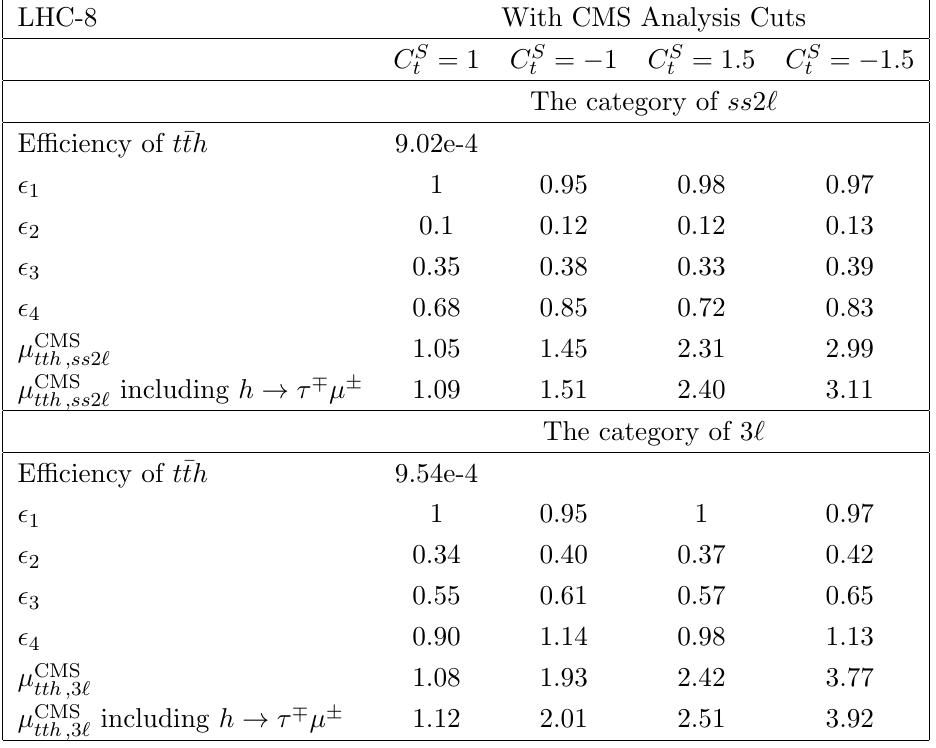
Table 5 . Category Leptons: the D -dependent detection e(cid:14)ciency ratios (cid:15) i ’s de(cid:12)ned in eq. (2.10) p with the CMS cuts for the category Leptons taking C S = (cid:6) 1 ; (cid:6) 1 : 5 and s = 8 TeV. The resulting t signal strengths (cid:22) CMS and (cid:22) CMS are also shown. The last row in each partition shows the values tth;ss 2 ‘ tth; 3 ‘ of (cid:22) CMS and (cid:22) CMS including the contributions from h ! (cid:22) (cid:6) (cid:28) (cid:7) tth;ss 2 ‘ tth; 3 ‘